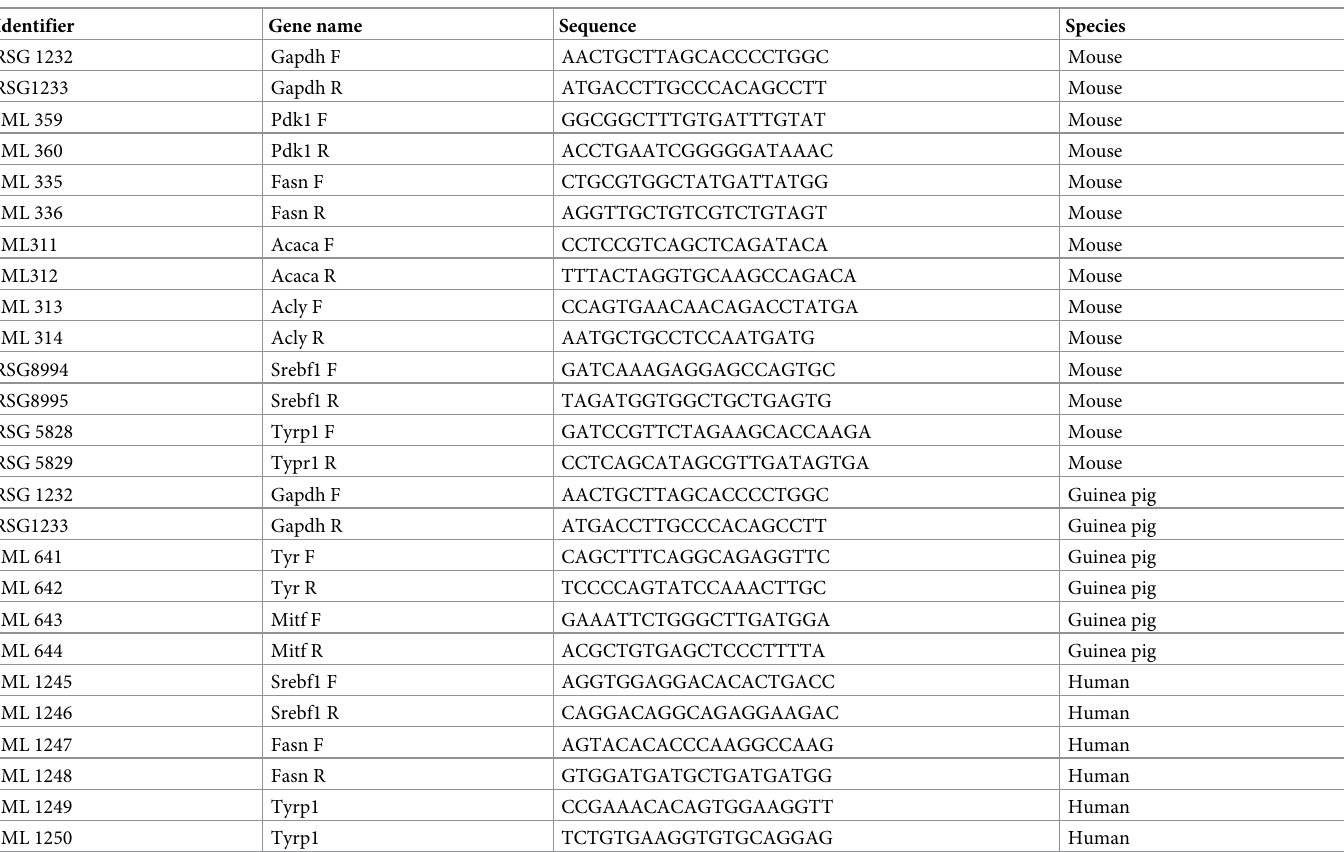
Table 1. List of qRT-PCR